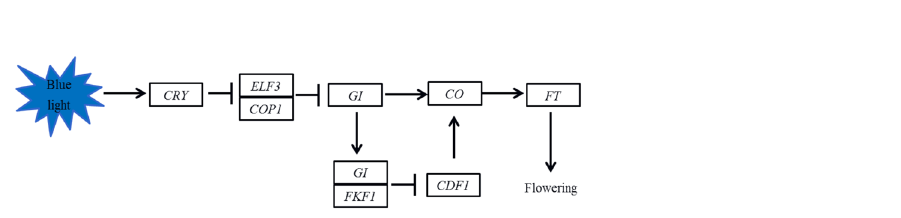
Figure 3. Schematic diagram of part of plant circadian rhythm pathway (map04712) 26 . This figure was created using Microsoft PowerPoint 2010.